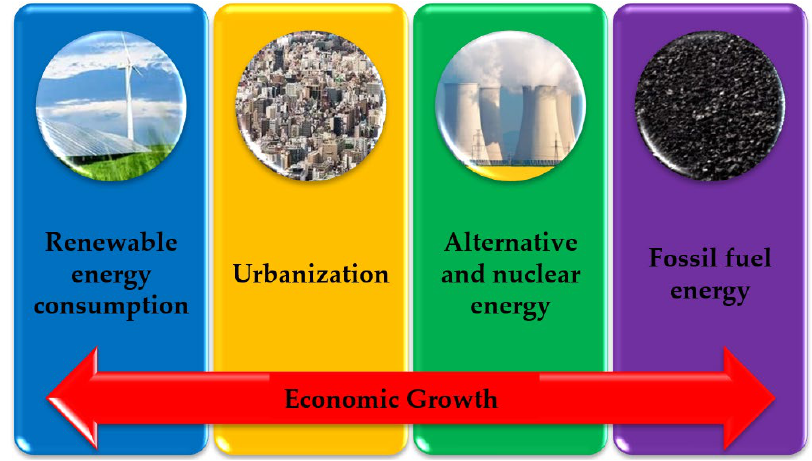
Figure 1. Variables nexus for the study (author’s own illustration).